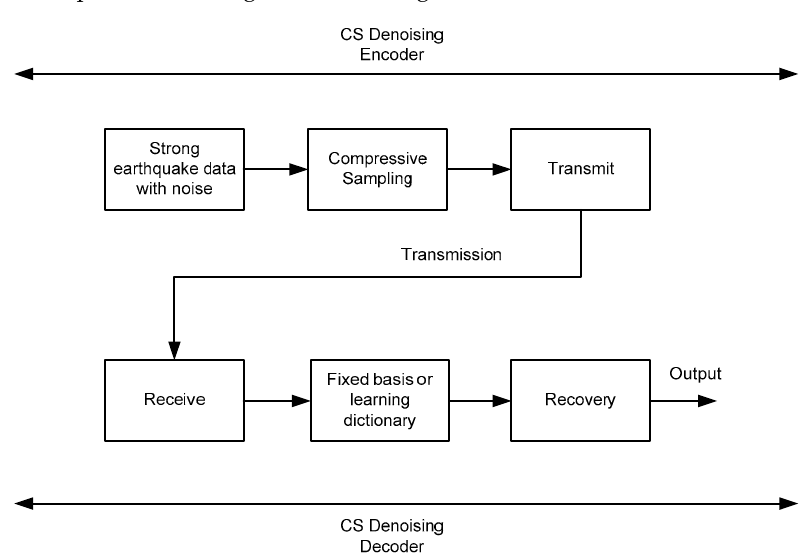
Figure 2. Process Flow of Strong Earthquake Data Denoising Based on Compressive Sensing.